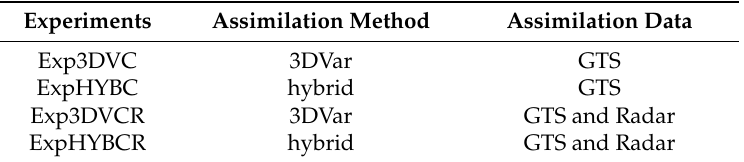
Table 1. List of